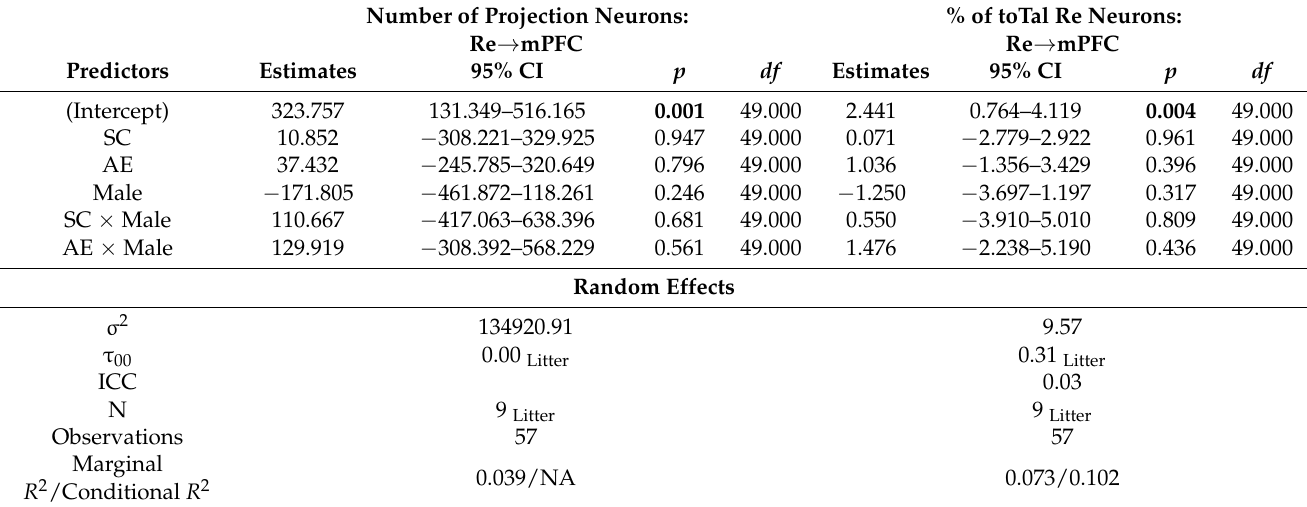
Table 5. Regression table for Re → mPFC projection neurons, as visualized in Figure 2 and quantified in Figure 4. Table was generated using the “tab_model” function (df method = Satterthwaite) from the “sjPlot” package on “lmer” objects from the “lmerTest” package. Similar table controlling for injection properties (diffusion of AAVrg-CAG at the injection site (fixed effect), the amount of incubation time following AAV injection (fixed effect), and the fluorophore-site pairing (random effect)) can be found in the Supplementary Material (Section S.2.3). Significant predictors (i.e., p ≤ 0.050) are indicated by bold p -values.